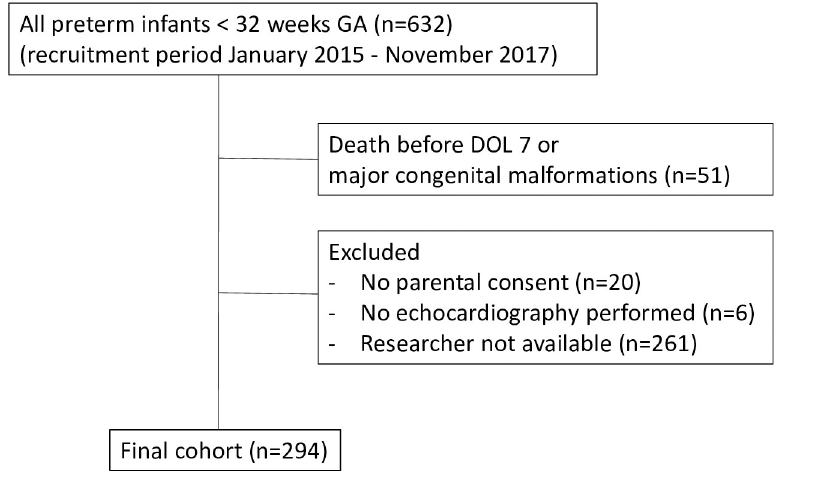
Fig 1. Recruitment flow